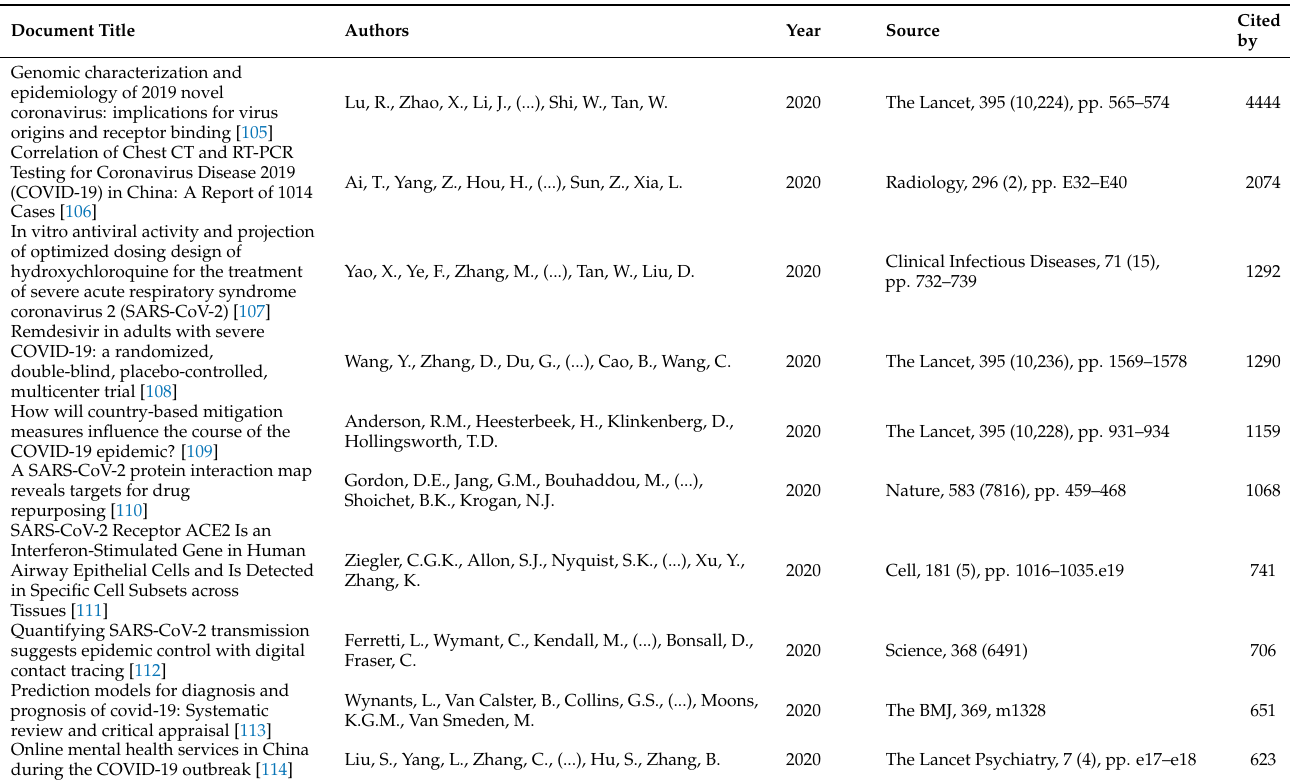
Table 3. Citation by number of